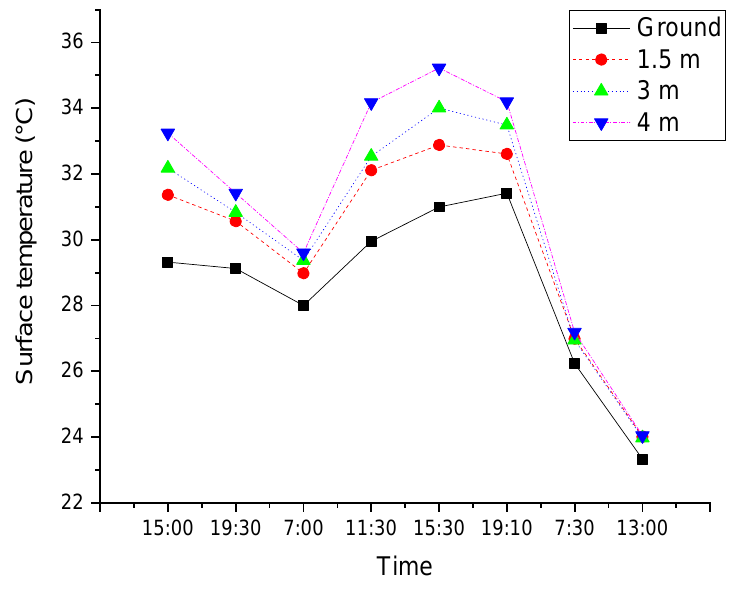
Figure 10. Temperatures at different heights.